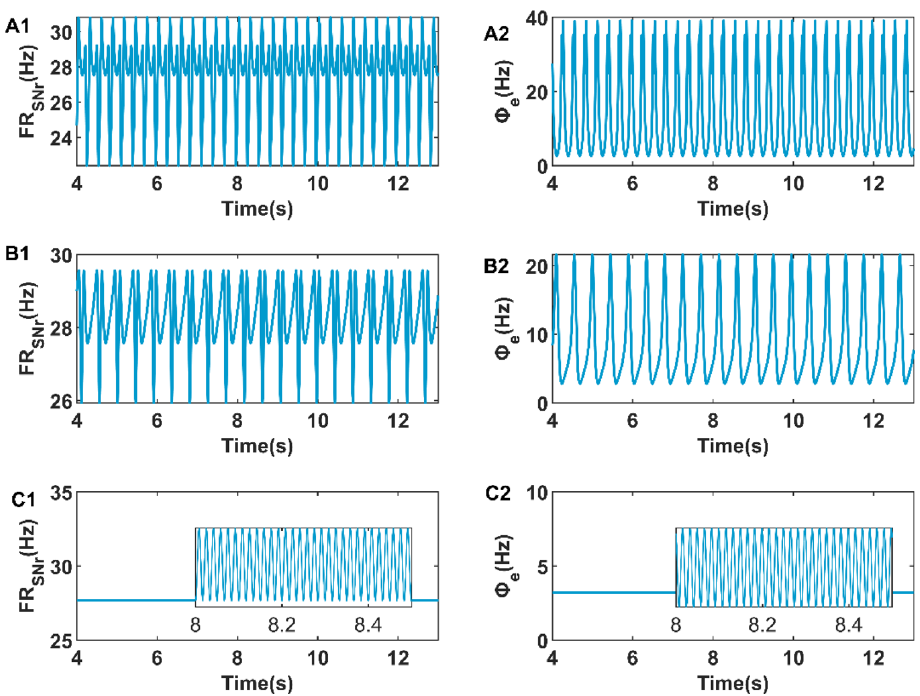
Figure 8. The firing rate of SNr when the amplitude of DBS stimulation is 1 mA ( A1 ), 3 mA ( B1 ), and 4 Hz ( C1 ). The firing activity of cerebral cortex when the amplitude of DBS stimulation is 1 mA ( A2 ), 3 mA ( B2 ), and 4 mA ( C2